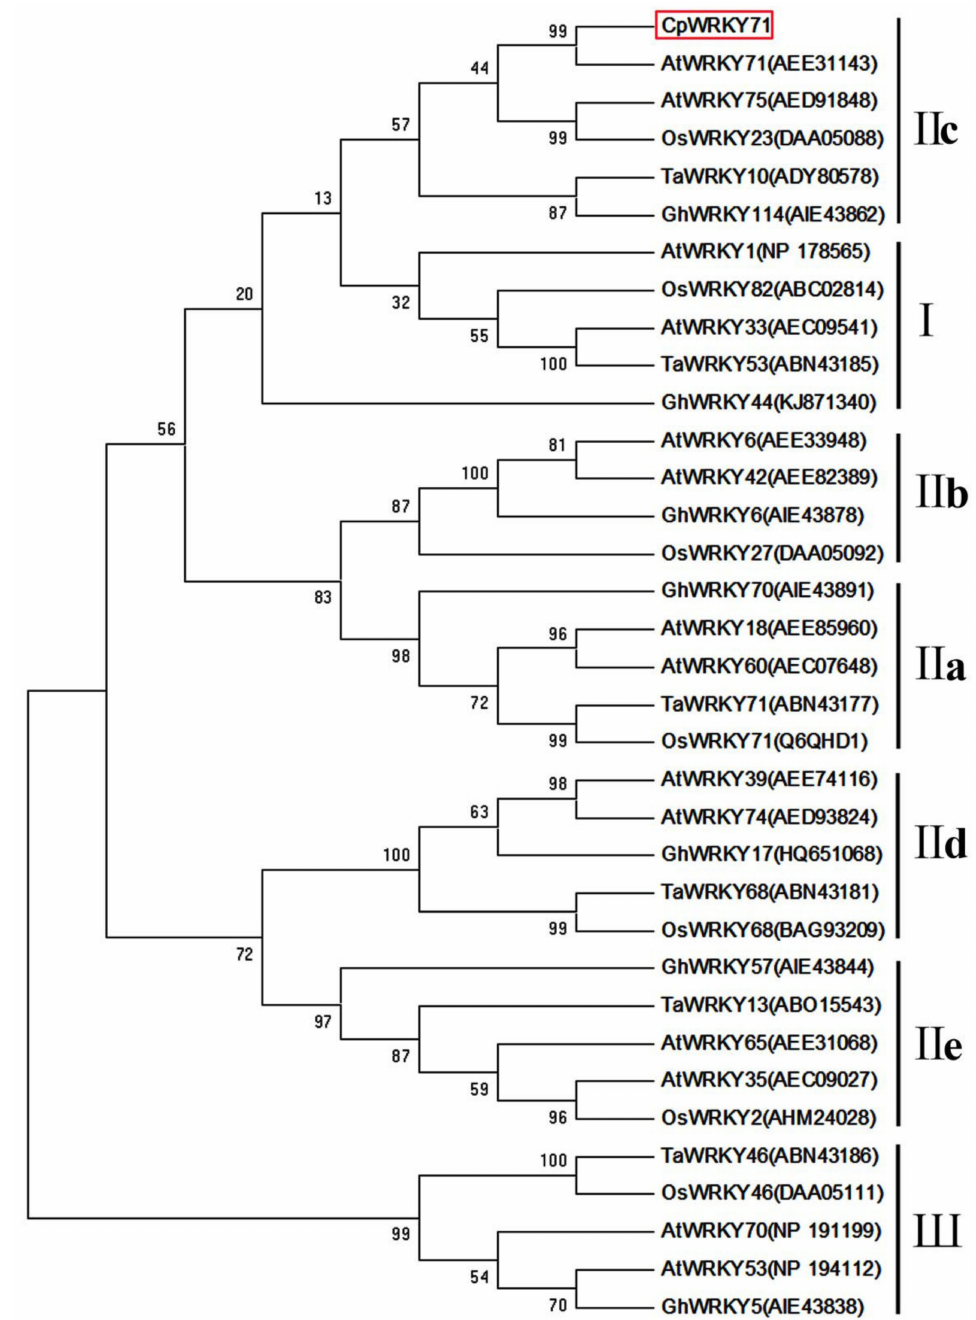
Figure 2. Phylogenetic tree of CpWRKY71 and WRKY proteins from other plant species. Phylogenetic analysis was performed by the neighbor-joining (NJ) method with 1000 bootstrap replicates using MEGA 5.0. At, Arabidopsis thaliana ; Gh, Gossypium hirsutum ; Ta, Triticum aestivum ; and Os, Oryza sativa . GenBank accession numbers are in the brackets following the protein names. CpWRKY71 is marked by the red